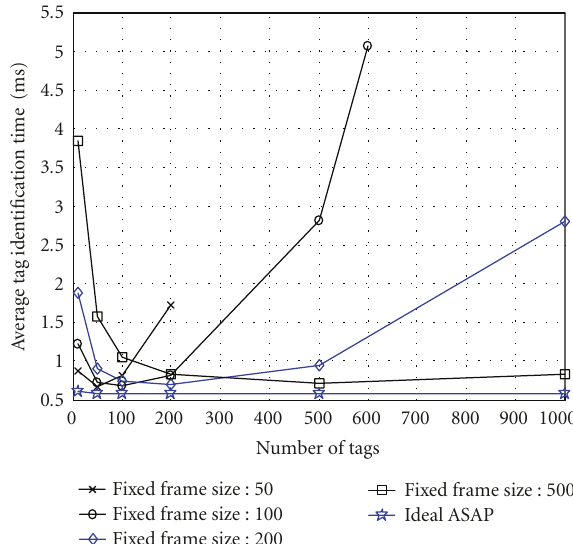
Figure 8: Performance of N = βK -type